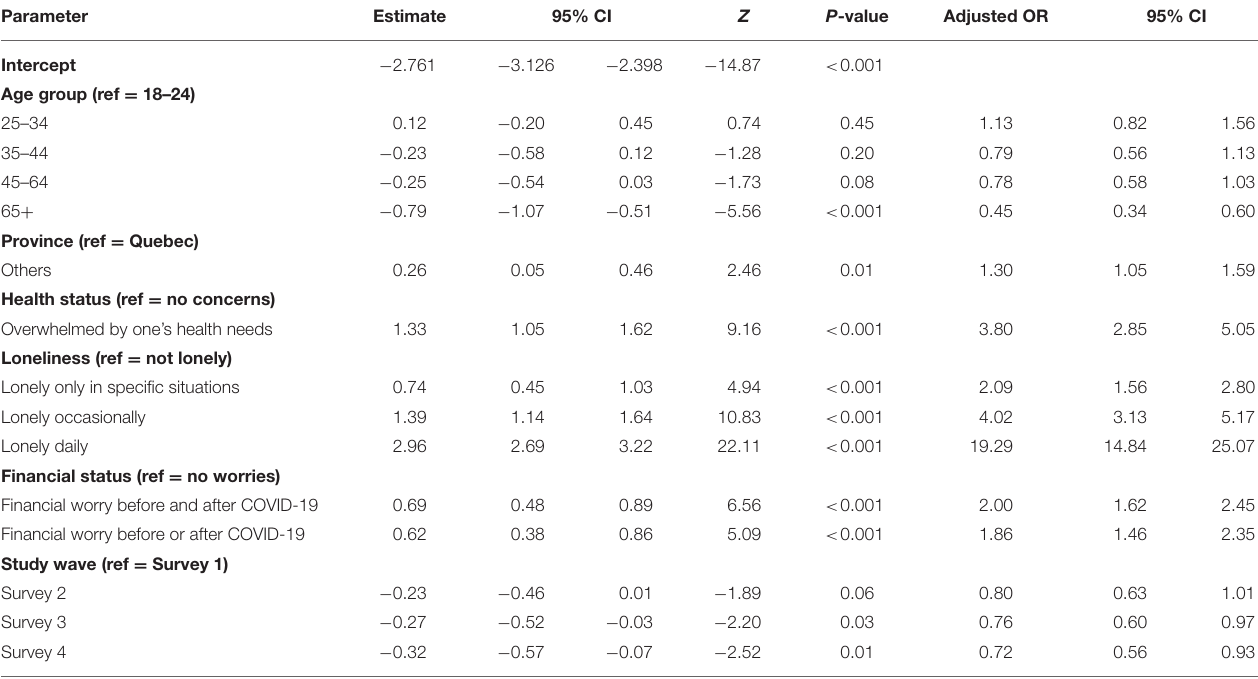
TABLE 3 | The association between the self-report mood scale score of 5 + and a number of risk factors over four study waves. Parameter Estimate 95%